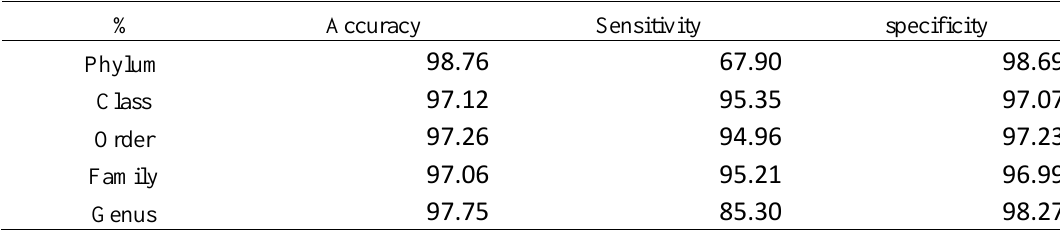
Table 2. Accuracy, Sensitivity, and specificity of clustering in